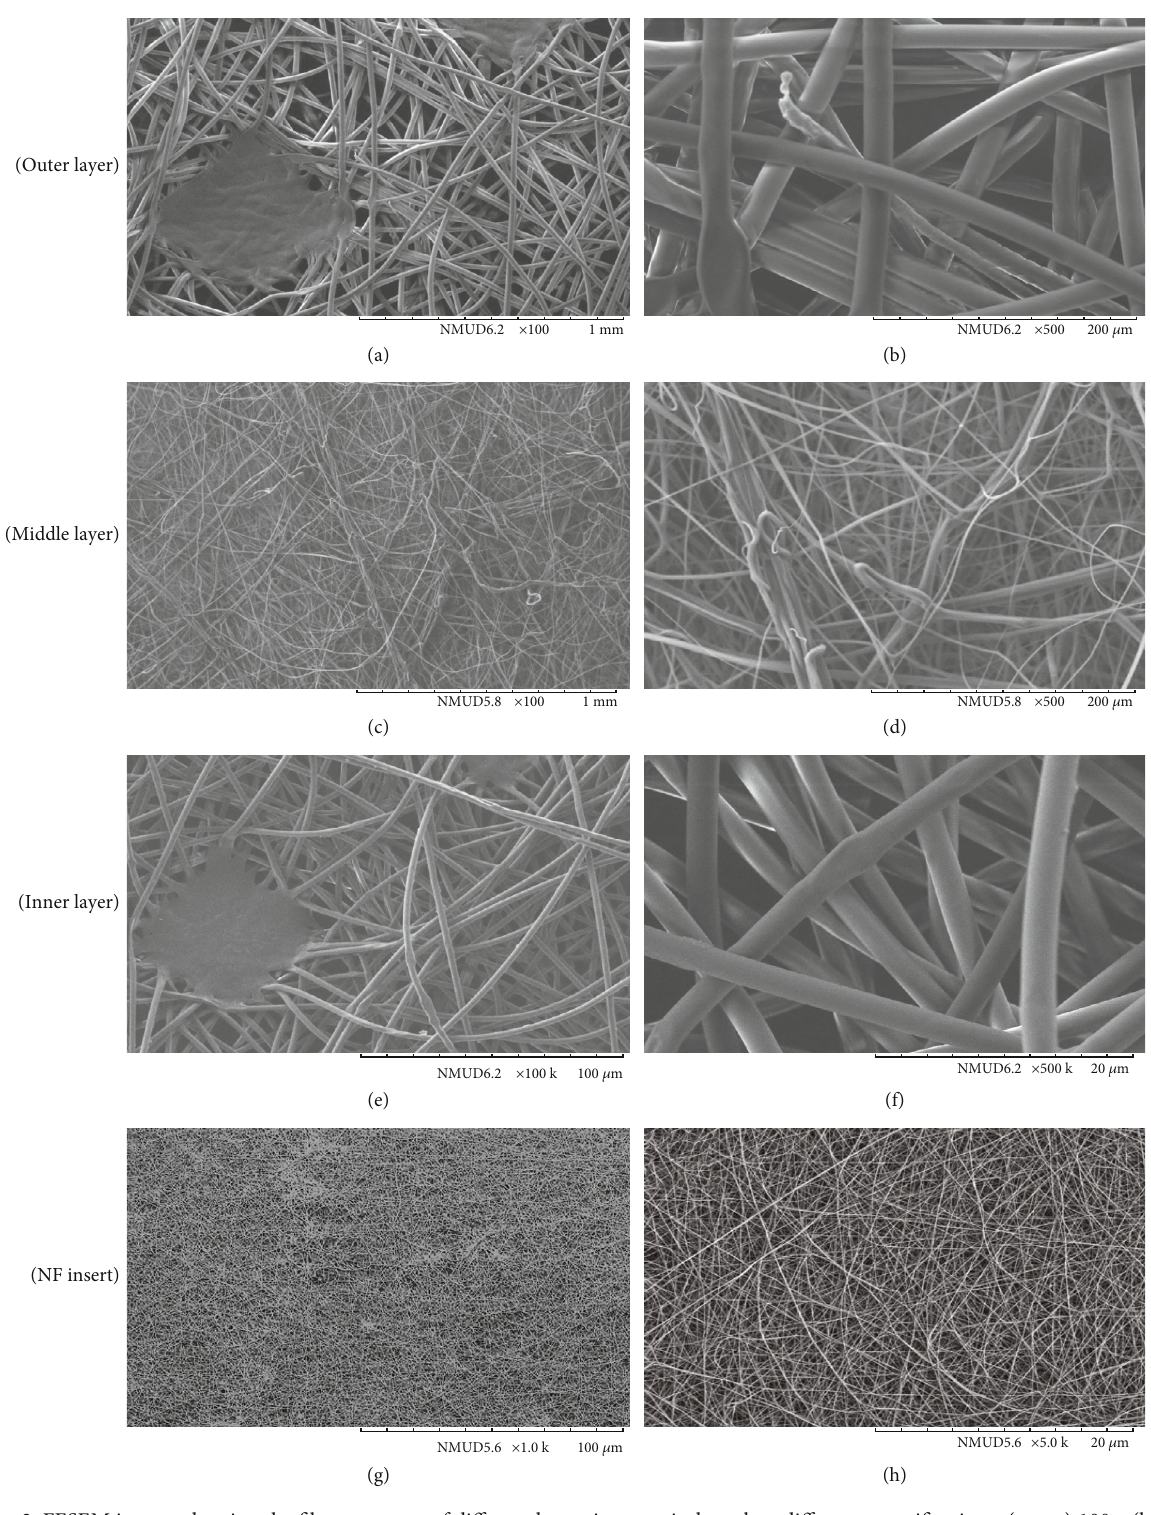
Figure 2: FESEM images showing the fi ber structure of di ff erent layers in a surgical mask at di ff erent magni fi cations: (a, c, e) 100x, (b, d, f) 500x, (g) 1000x, and (h)